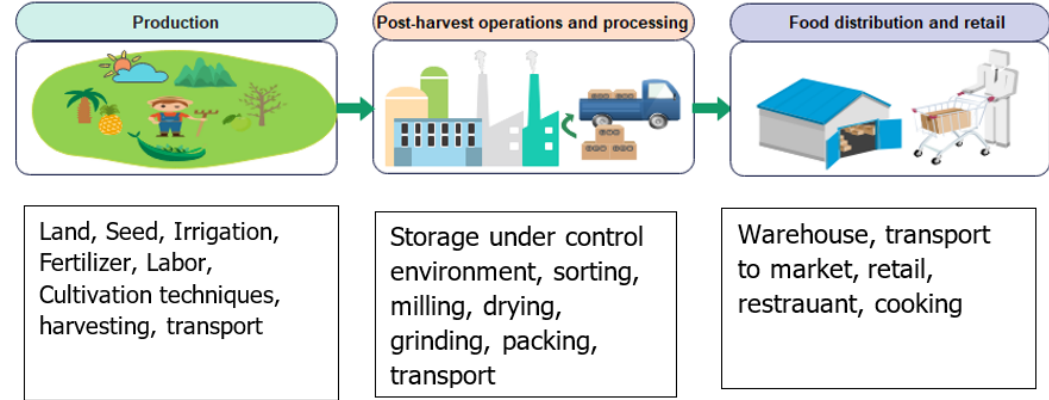
Figure 2. Typical food